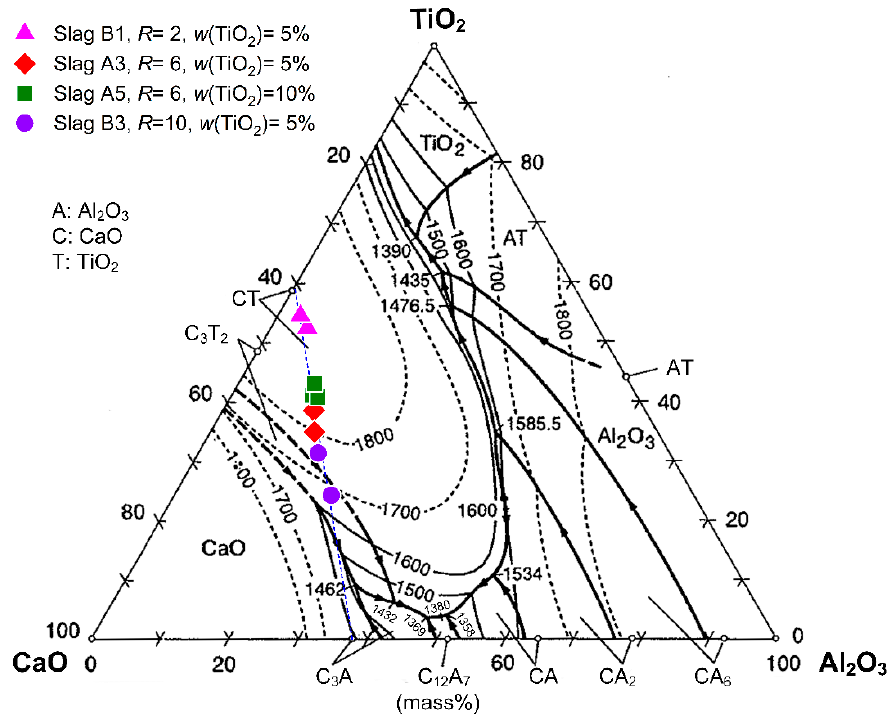
Figure 13. CTA composition plotted in CaO-Al 2 O 3 -TiO 2 liquidus projection. Adapted from Ref. [29].